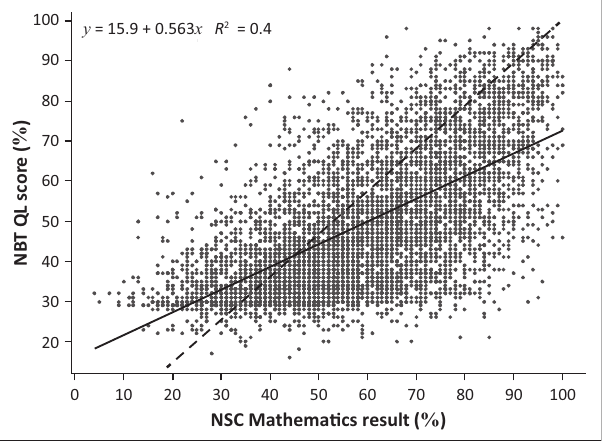
FIGURE 4: National Senior Certificate Mathematics and National Benchmark Test quantitative literacy scores ( N = 6 271).